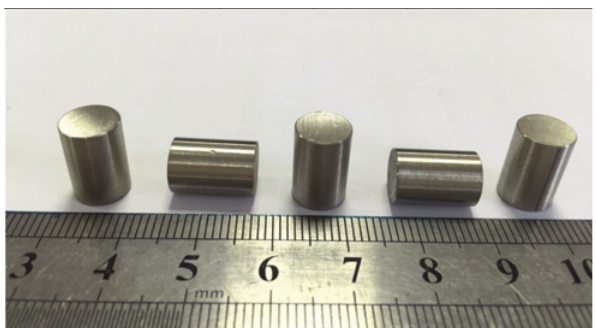
Figure 1: Typical appearance of the TA2